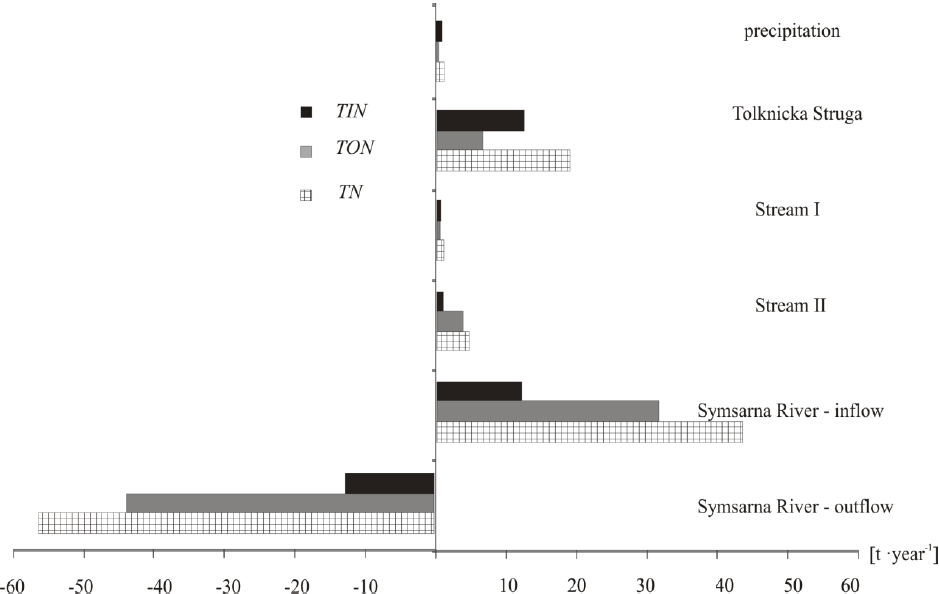
Figure 3. The input and output loads (by surface inflow/outflow and precipitation) of mineral nitrogen ( TIN ), organic nitrogen ( TON ), and total nitrogen ( TN ) to/from Symsar Lake. The two analysed PCA axes explain 67.3% of the variability in the nitrogen concentration and physical properties under study in relation to environmental factors such as the location of surface water (i.e., inflow, outflow and two sites in the reservoir), season (growing season and non-growing), monthly sum of precipitation, average monthly air temperature, and average monthly stream water flow. The first axis (PCA1) was shown to be closely correlated with the environmental data, especially with the meteorological conditions, while the second axis (PCA2) showed a relatively lower level of correlation (23.8%, Table 2). Table 2. Results of the ordination diagram of the PCA.